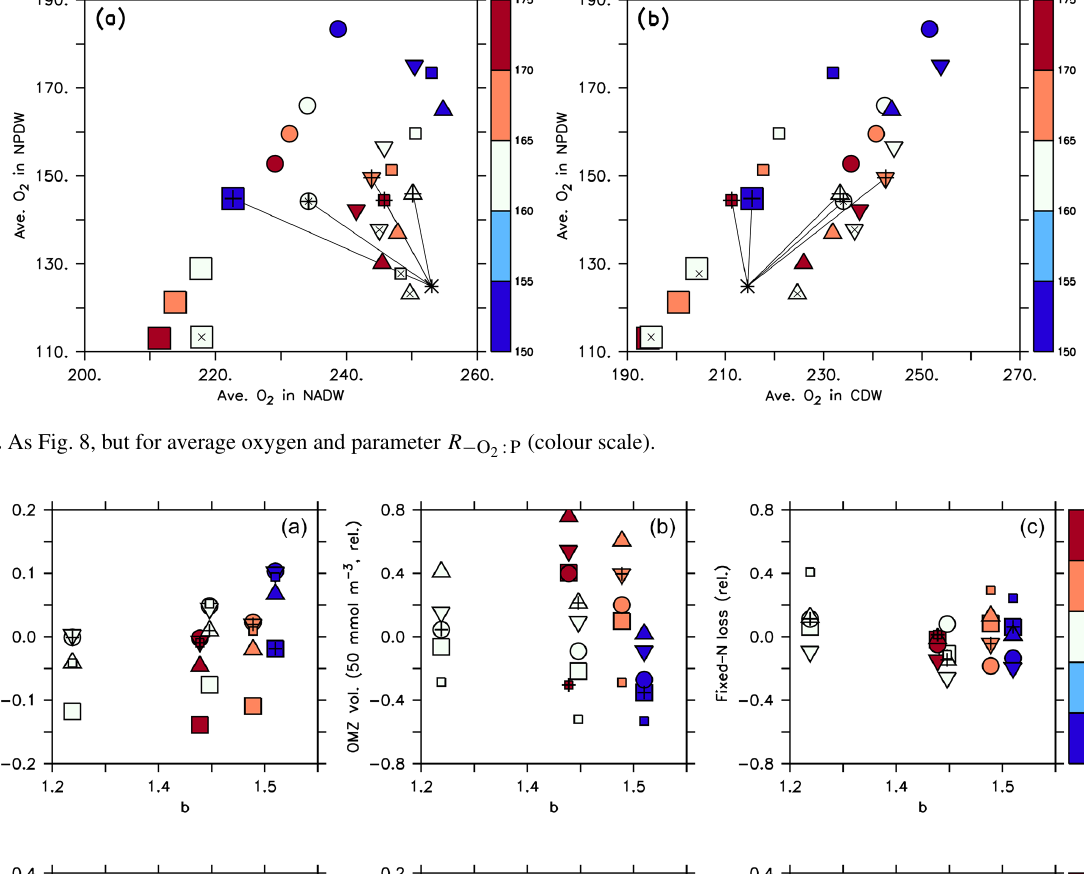
Figure 10. Normalised biogeochemical diagnostics plotted against parameter b : (a) global average oxygen, (b) OMZ volume defined by concentrations < 50mmolm − 3 , (c) global fixed N loss, (d) global primary production, (e) export production and (f) organic particle flux at − 1), where j and i 2000m. All diagnostics X expressed as relative deviation to the mean of the five optimal model simulations ( X i,j /X ∗ i denote different combinations of circulation j and parameter set i , and X ∗ is the average of all optimal model configurations (see Table 3 for j values). Colour denotes the value of parameter R − O . Symbols denote circulation. Small squares: parameter set of MIT28 ∗ . Large squares: 2 : P ECCO ∗ . Circles: UHigh ∗ . Triangles: U20 ∗ . Inverted triangles: U17.5 ∗ . (See also symbol legend in Fig. 6.) Optimal model configurations are indicated by